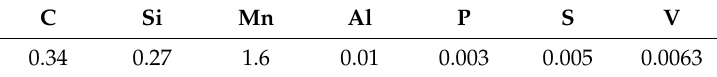
Table 8. Chemical composition of molten steel (mass%).